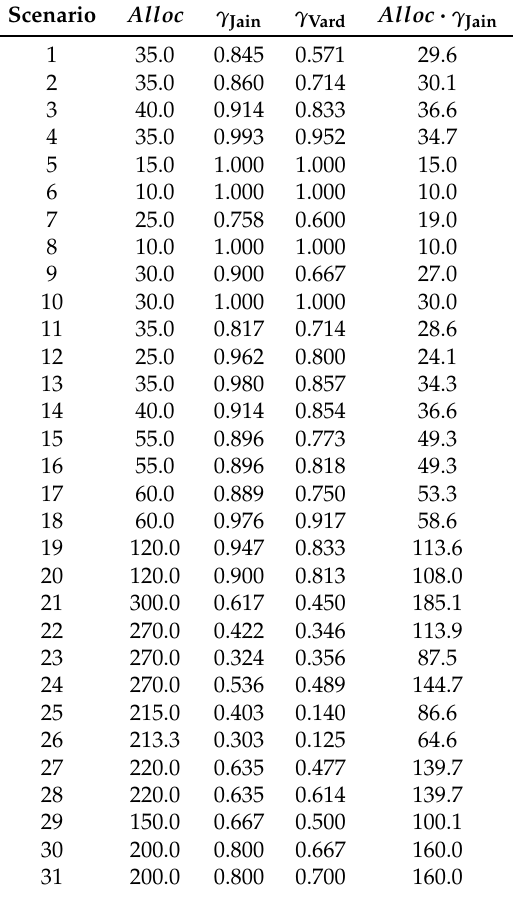
Table 10. Performance evaluation for BSF-I. Alloc values in Mbps.